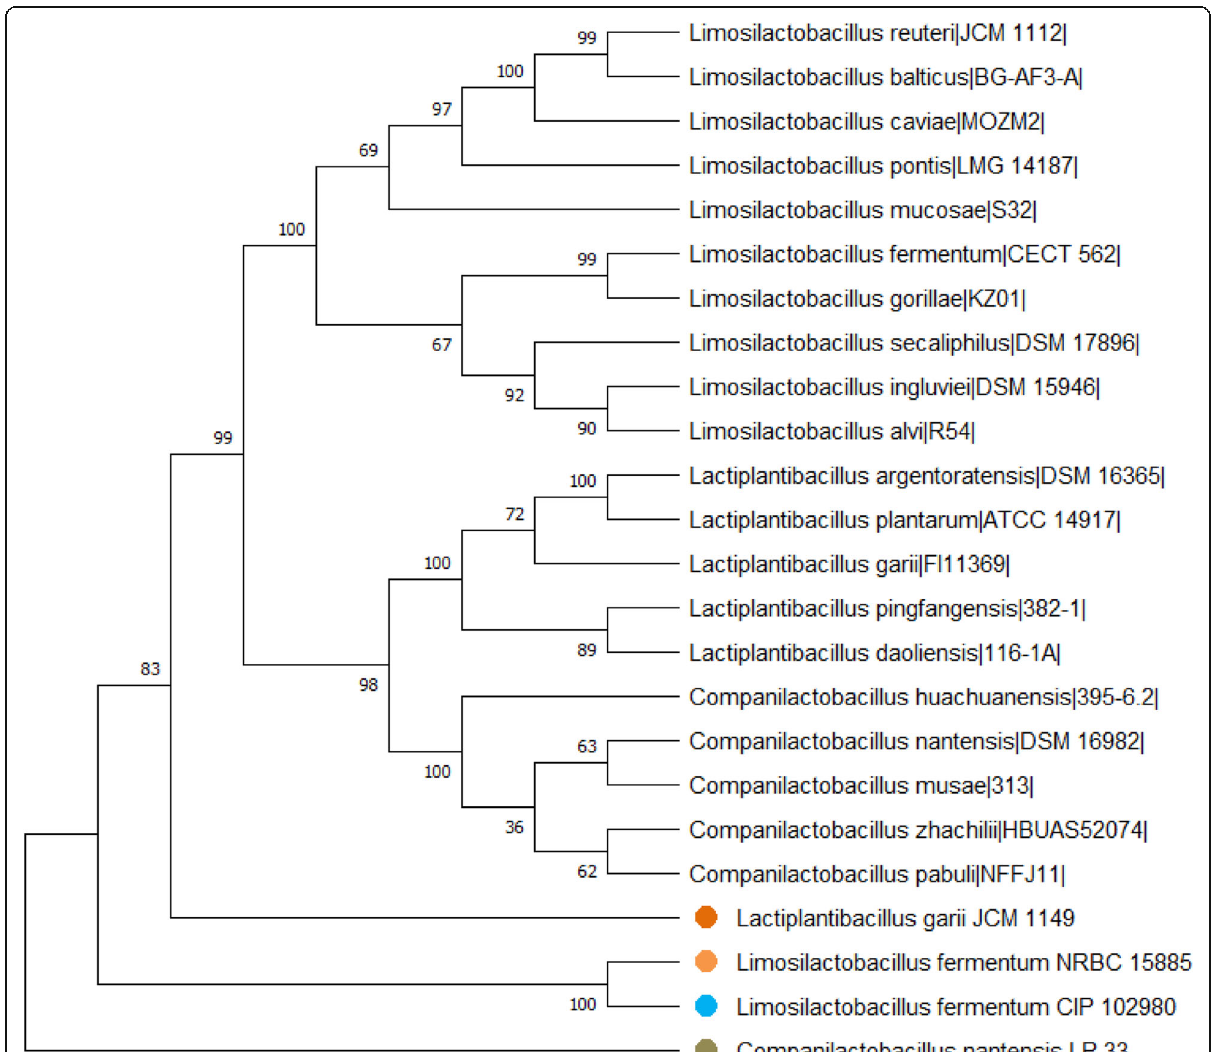
Fig. 6 Phylogenetic analysis of 16S rRNA sequences of the bacterial isolates with the sequences retrieved from EzTaxon